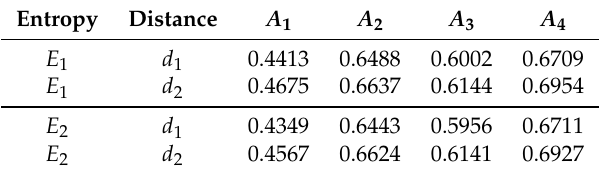
Table 3. Dual hesitant weighted distances of alternatives to NIS.